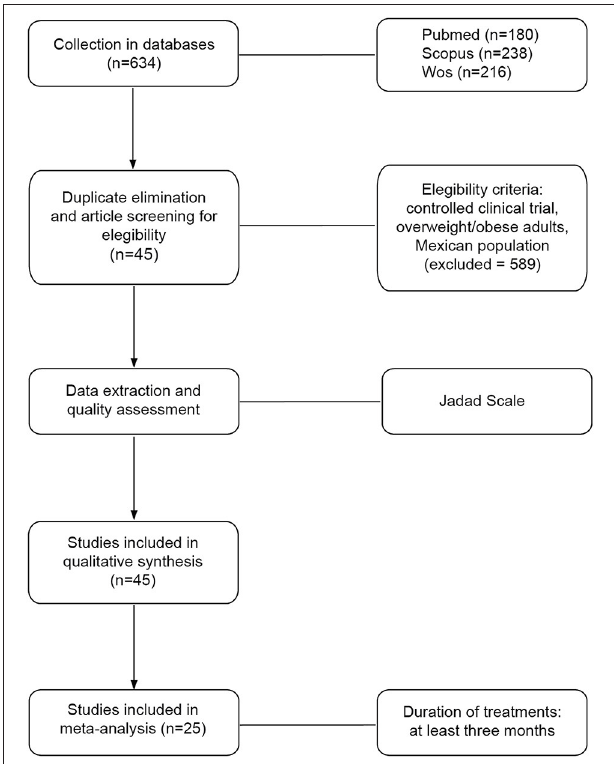
FIGURE 2 | Study framework for systematic review with meta-analyses. The flowchart shows the processes of collection, screening, quality assessment, data extraction, and